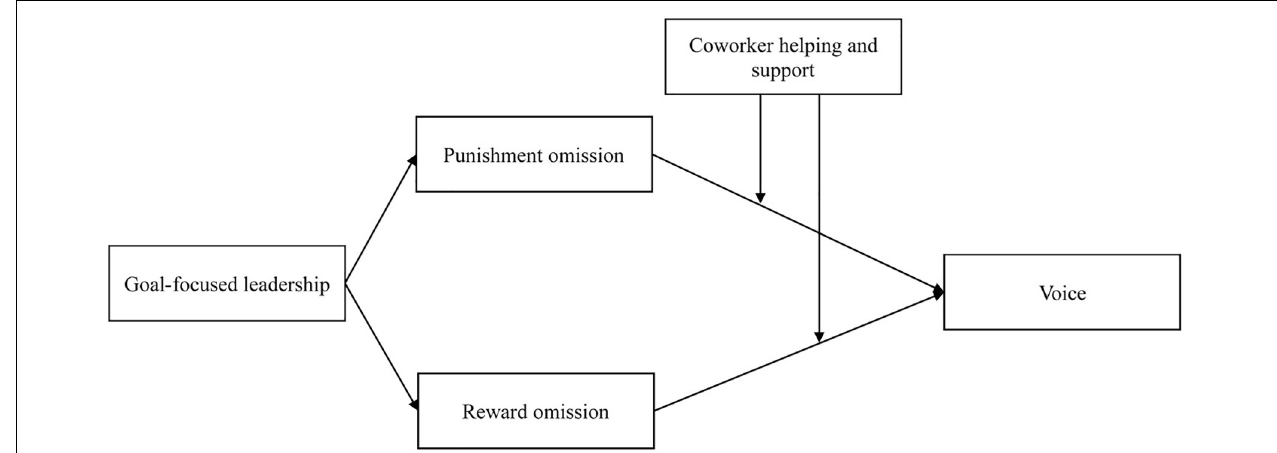
FIGURE 1 | Theoretical